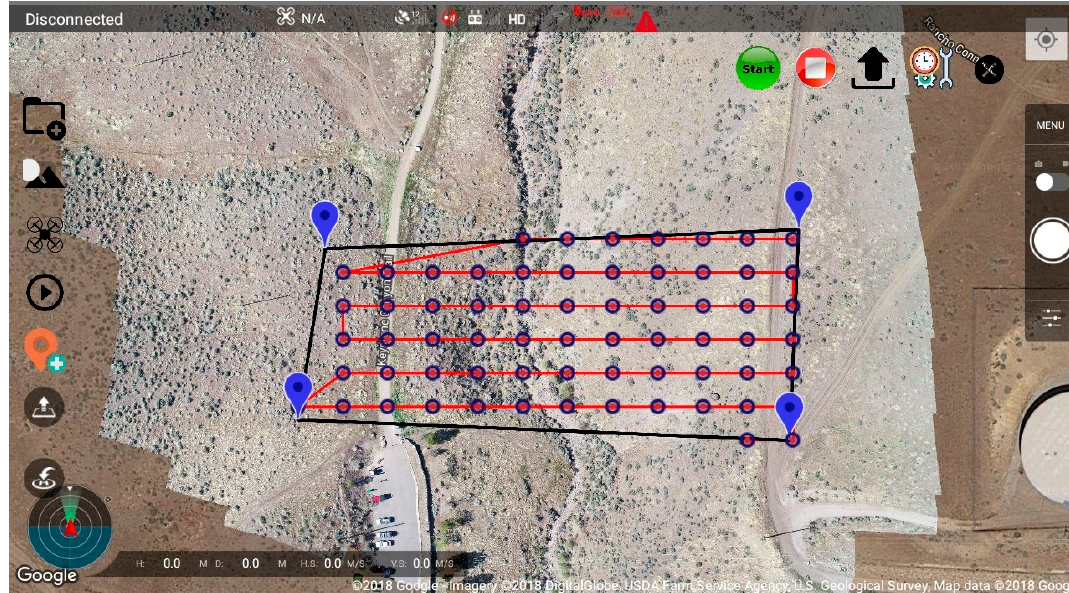
© Figure 7. ( a ) Ground control points (GCPs) at Keystone Trailhead; ( b ) X-mark GCP; ( c ) Survey stake. Placement and surveying of GCPs took around 1.5 h. Once this was completed, the Stage 1 flight was conducted over the area with a DJI Phantom 4 Pro UAV. Collected images from the flight were processed using PhotoScan to generate a point cloud, a DEM, and an orthomosaic of the area. The orthomosaic and the DEM were then imported into the designed mobile application to plan and execute the Stage 2 flight with the terrain-awareness feature enabled for an area of interest [27]. Characteristics for Stage 1 and Stage 2 flights are shown in Table 2, and the estimated UAV path for the Stage 2 flight is depicted by the red polyline in Figure 8. The altitude for the Stage 2 flight was set to a lower value of 36.5 m compared to 60 m for the Stage 1 flight to generate sub-millimeter